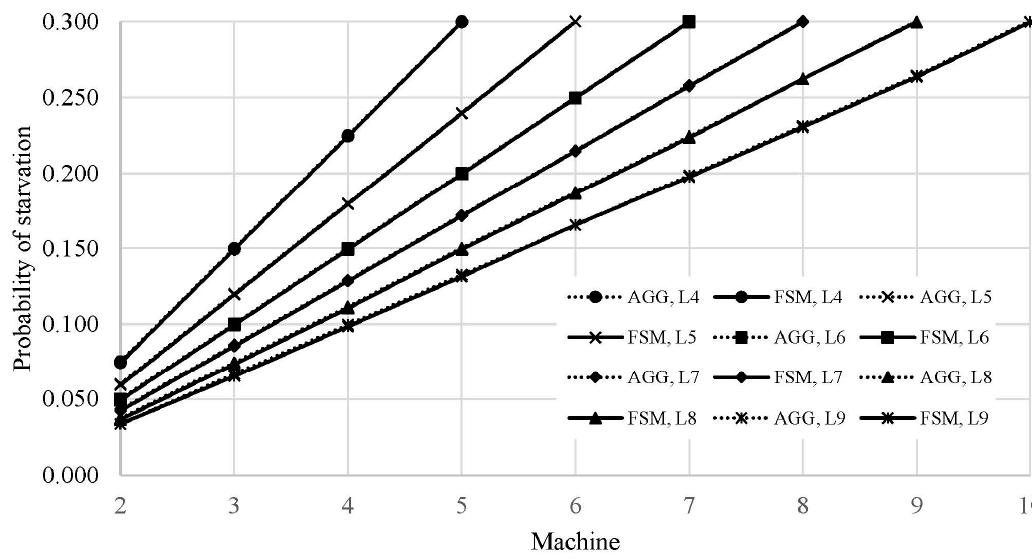
Figure 13. Asymptotic probability of the starvation, lines L 4 –L 9 (authors’ work).